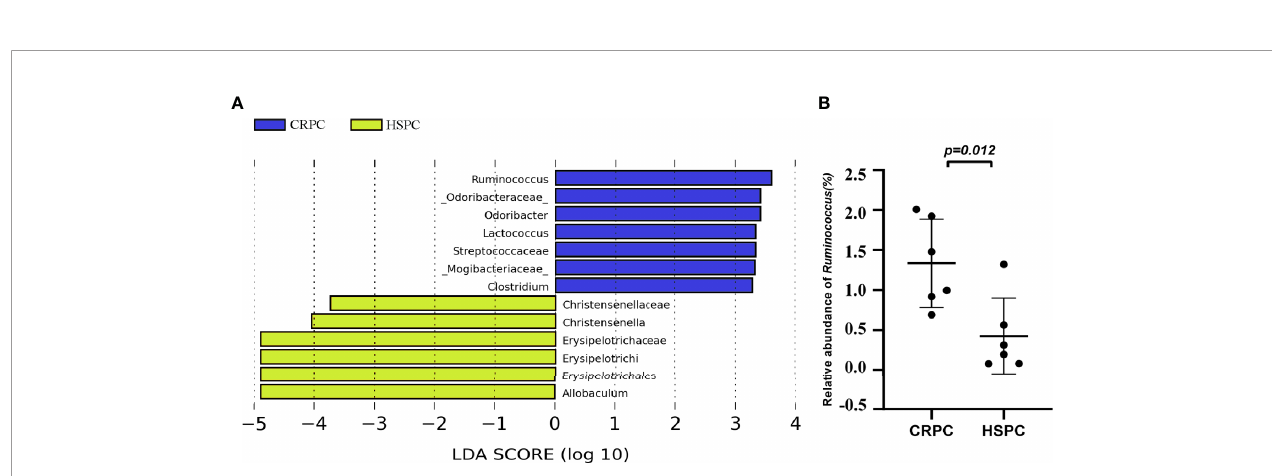
FIGURE 4 | FMT with CRPC feces increased mice ’ s gut Ruminococcus . (A) 16s rRNA sequencing identi fi ed increased gut Ruminococcus in CRPC FMT treated mice. (B) Relative abundance of Ruminococcus between two groups of mice after FMT. The bars represents mean ±